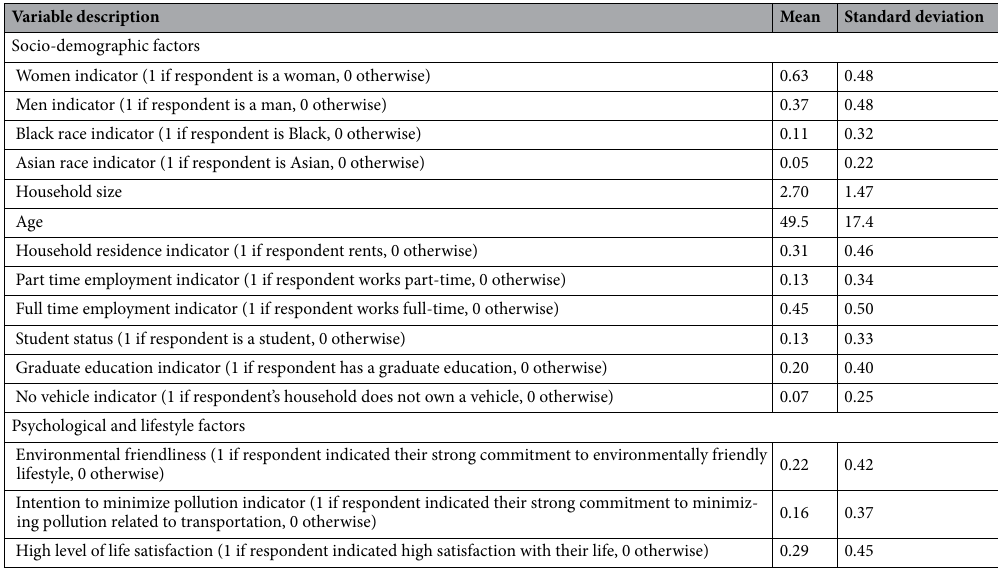
Table 1. Summary statistics for variables included in final model